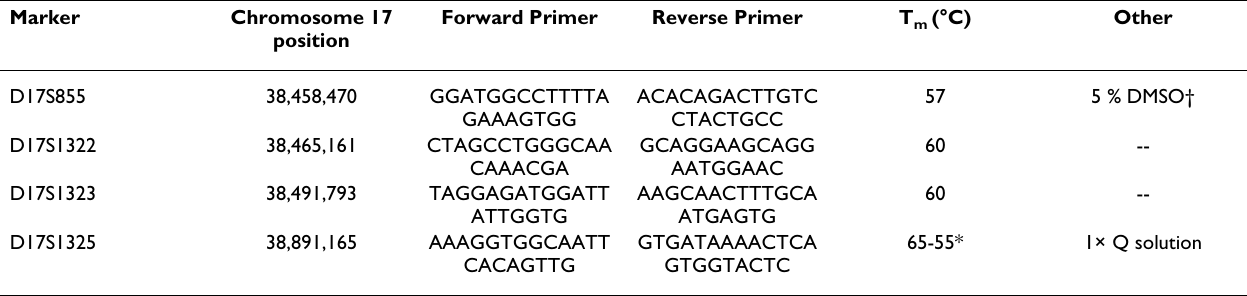
Table 2: Primers used to generate the haplotype Marker Chromosome 17 Forward position